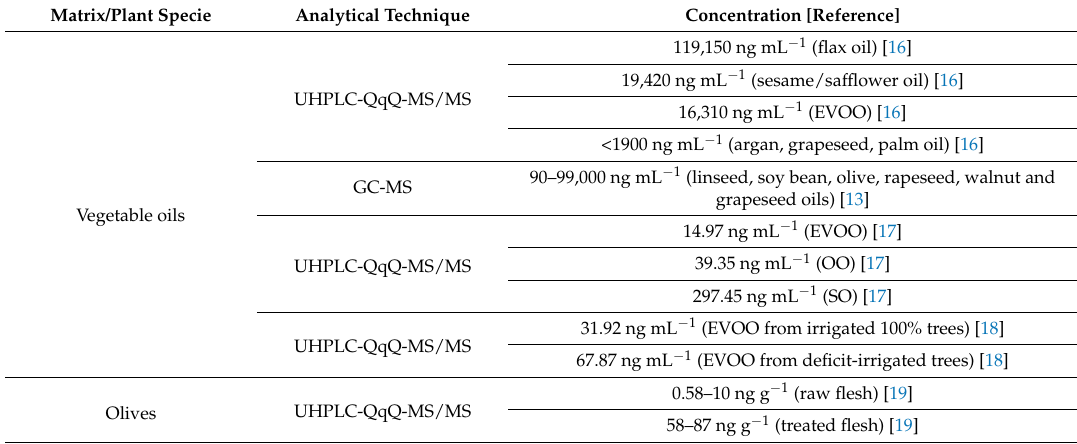
Table 1. Natural occurrence of phytoprostanes in vegetables